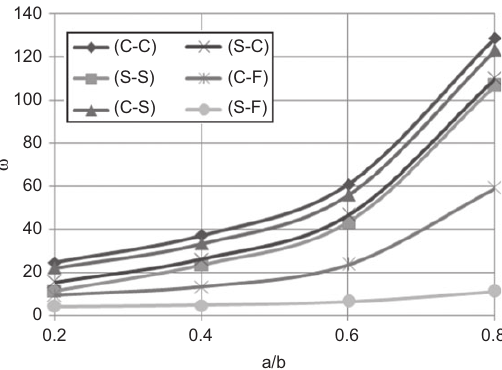
Table 1 Comparison of the present finite element solutions with the literature results for the isotropic annular plates.